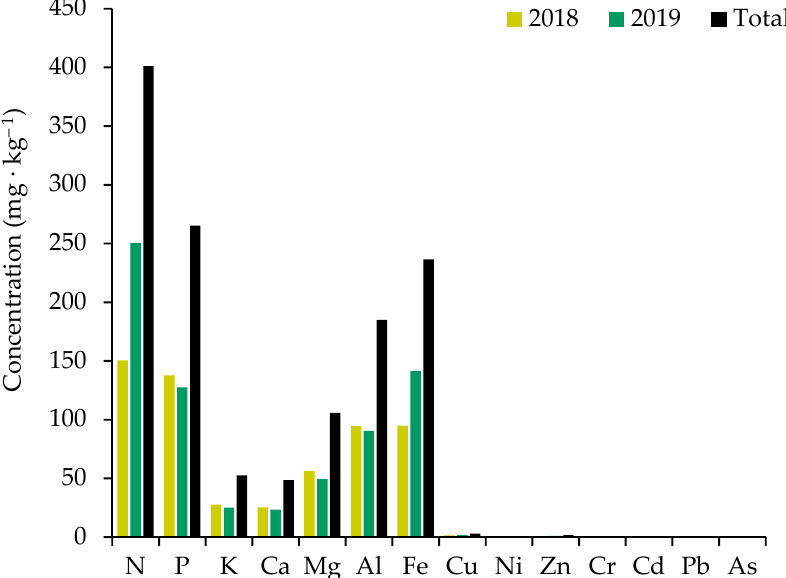
Figure 6. Nutrient and heavy metals concentrations in WW-treated soil (Outokumpu area) at the end of growth seasons (n = 3; depth 0–30 cm).